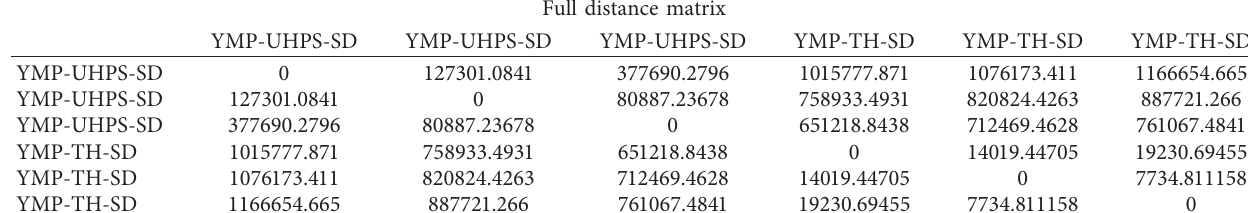
Table 3: Euclidean distances of YMP-UHPS-SD and YMP-TH-SD.